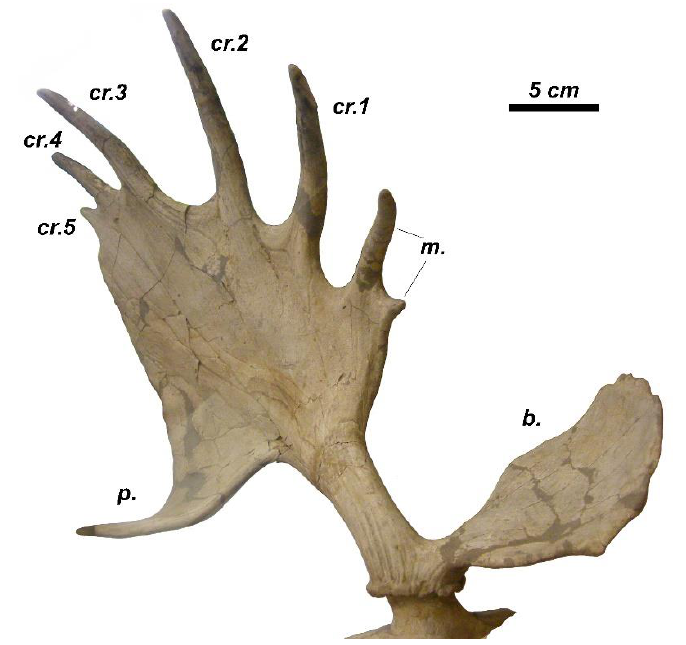
Figure 10. Medial view of right antler of the holotype of Megaloceros giganteus antecedens (Berckhemer, 1941). Abbreviations as in Figure 3.